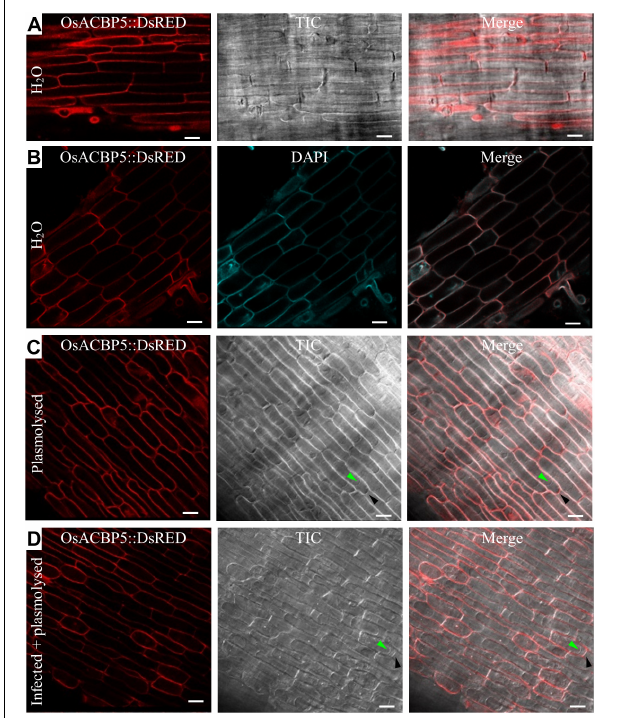
FIGURE 4 | Subcellular localization of OsACBP5:DsRED in transgenic rice after plasmolysis and Rhizoctonia solani infection. Root cells of 4-day-old transgenic rice seedlings were imaged by confocal laser scanning microscopy. (A) Signals of OsACBP5:DsRED were detected at plasma membrane or cell wall when incubated in water. (B) Colocalization of OsACBP5:DsRED (red) with 4 (cid:48) ,6-diamidine-2 (cid:48) -phenylindole dihydrochloride (DAPI) (blue) (10236276001, Roche) at cell wall in root cells of 4-day-old transgenic rice seedlings when incubated in water. As DAPI cannot penetrate the live cell, it was used as a cell wall/extracellular space stain here. (C) Signals of OsACBP5:DsRED were detected at cell wall in root cells of 4-day-old transgenic rice seedlings after plasmolysis. (D) Signals of OsACBP5:DsRED were detected at cell wall in root cells of 4-day-old transgenic rice seedlings after infection and plasmolysis. Green arrow indicates plasma membrane and black arrow shows cell wall. Bars = 20 µ m. ACBP, acyl-CoA-binding protein; Os, Oryza sativa . Representative images are presented following observation with consistent results from at least 20